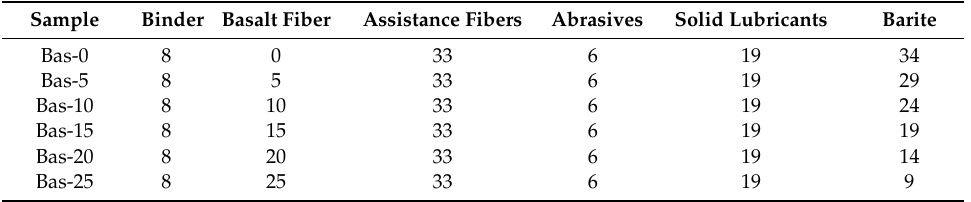
Table 1. Composition of Basalt fiber sliders (wt%).